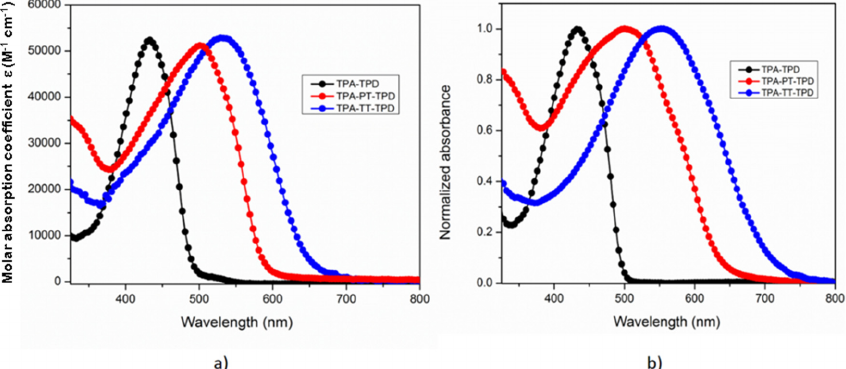
Figure 2. Ultraviolet–visible (UV-Vis) absorption spectra of TPA-TPD , TPA-PT-TPD and TPA-TT-TPD ( a ) In solution (CHCl 3 ); ( b ) In solid-state films.